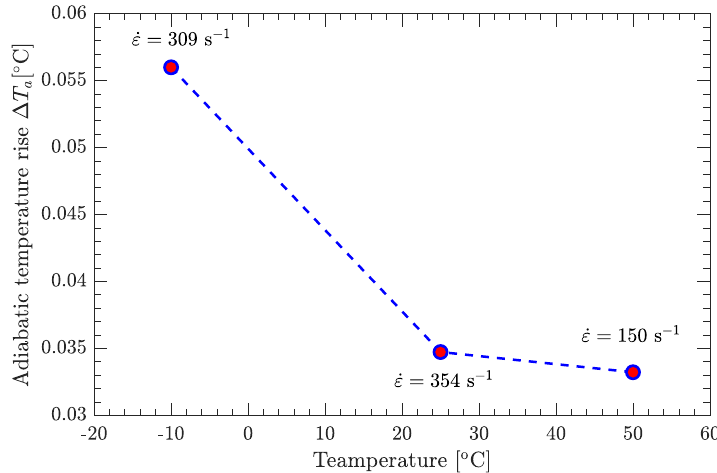
Figure 17. Adiabatic temperature rise due to plastic work